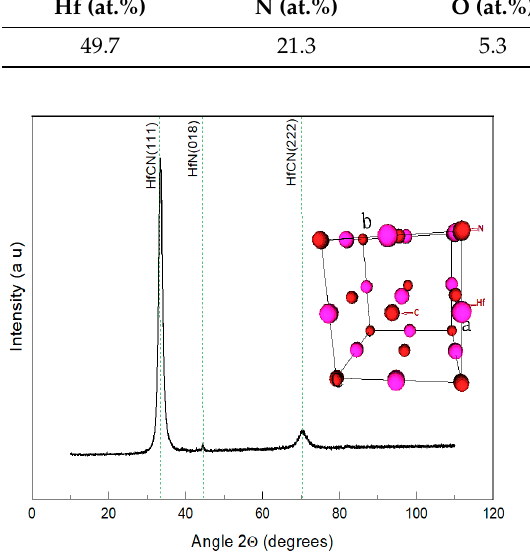
Figure 3. Di ff raction pa tt ern for HfCN. Figure 3. Diffraction pattern for